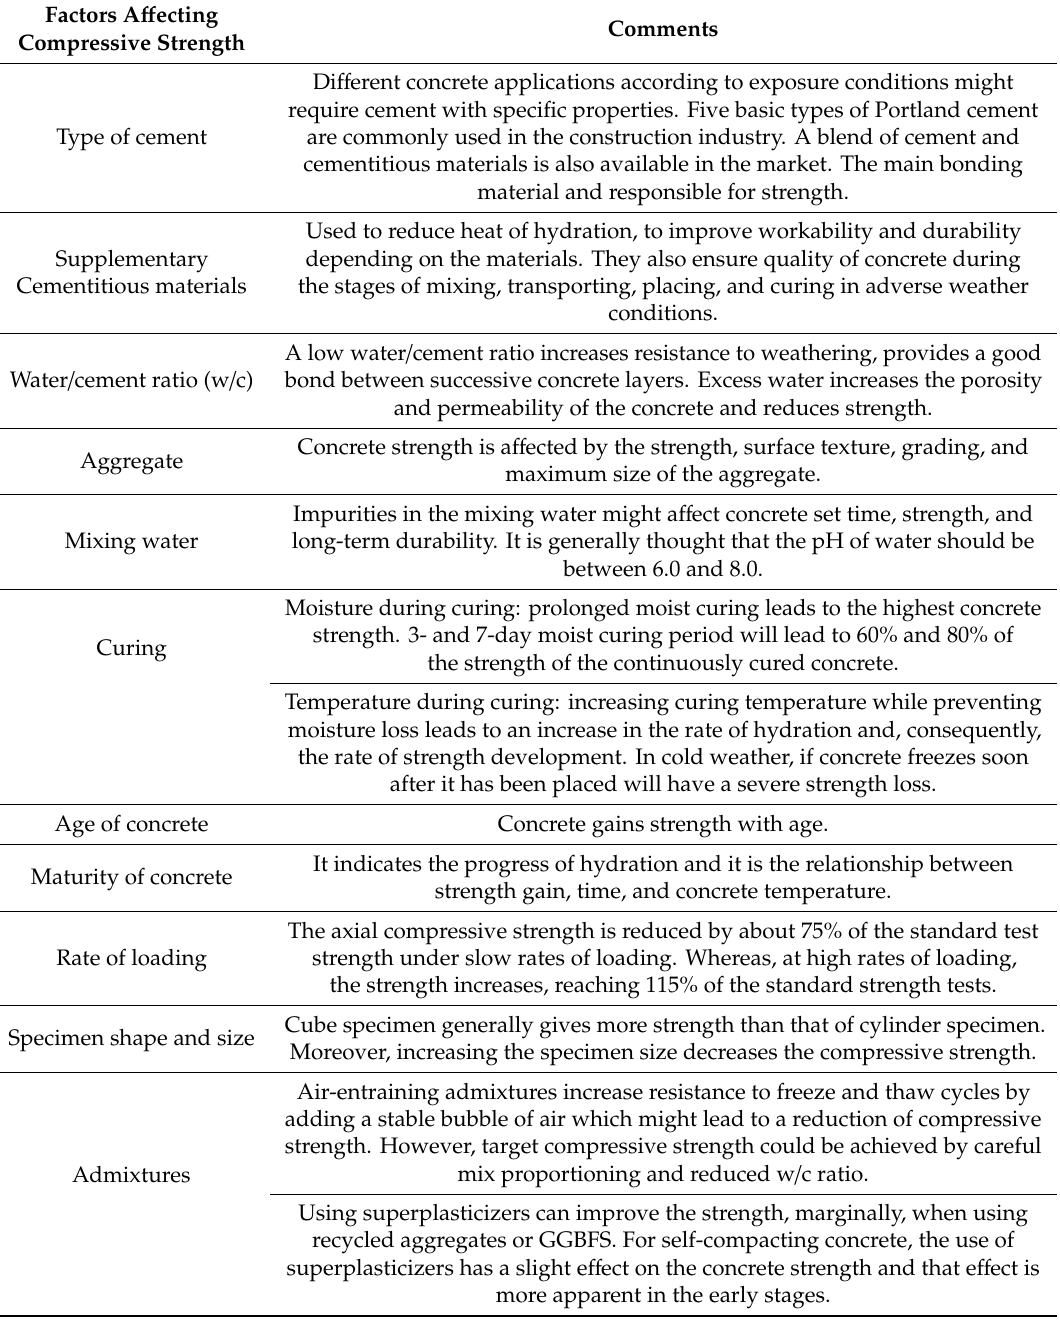
Table 1. Factors a ff ecting compressive strength of concrete